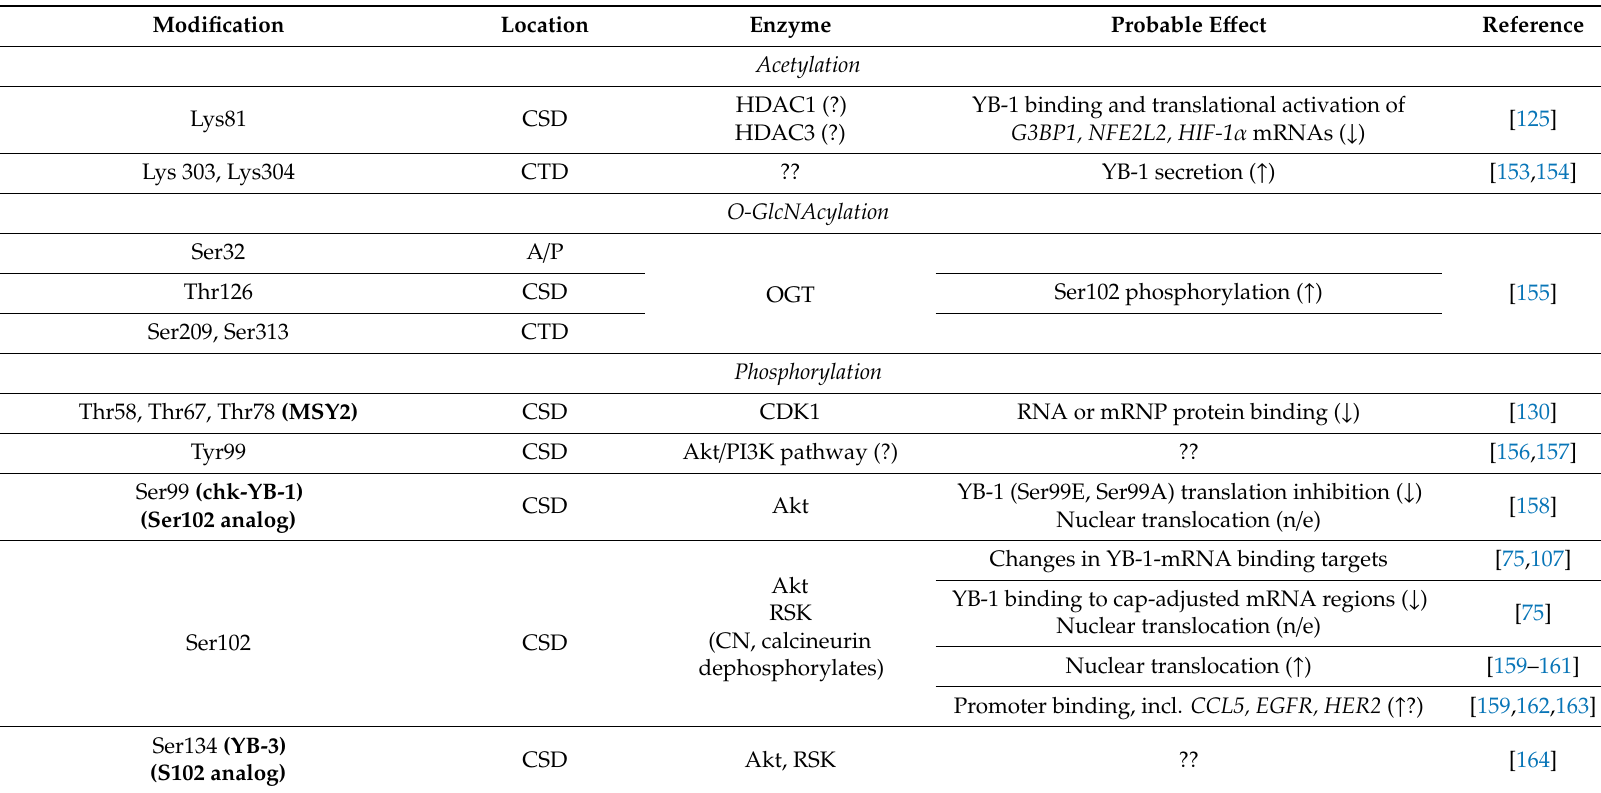
Table 1. Modifications of YB proteins and probable e ff ects on their functions. The complete list of detected modifications can be found at www.phosphosite.org. The names of respective YB proteins except YB-1 (default) are shown in bold in parentheses. Notation: ↑ —up-regulation; ↓ —down-regulation; n / e—no e ff ect; ?—indirect evidence; ??—unknown